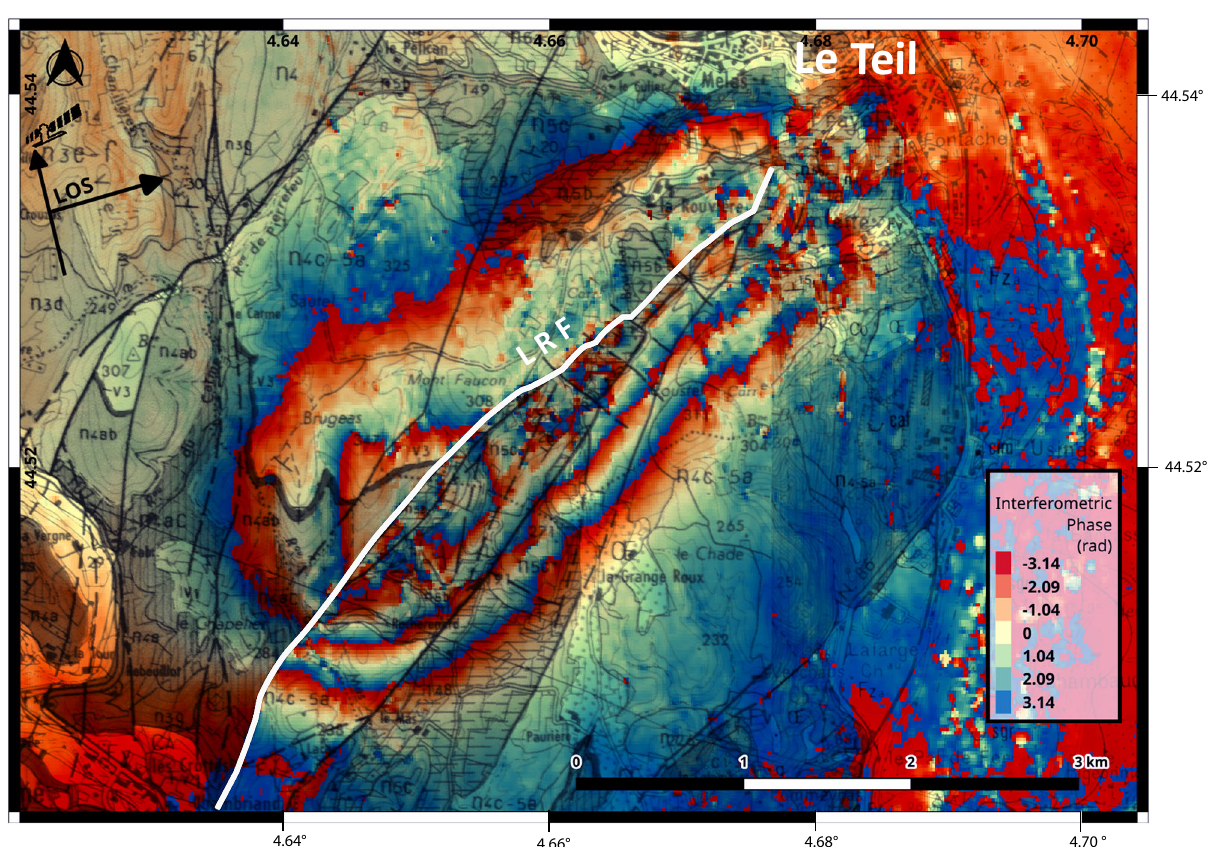
Fig. 3 First interferogram (wrapped phase) obtained using Sentinel-1 synthetic-aperture radar data. Pre-earthquake image is from 31 October 2019; post-earthquake image is from 12 November 2019 (12 days baseline). The black lines correspond to faults after the Aubenas geological map 4 . The white line de fi nes the ~5-km-long northern section of the La Rouvière Fault (LRF) matching with the InSAR